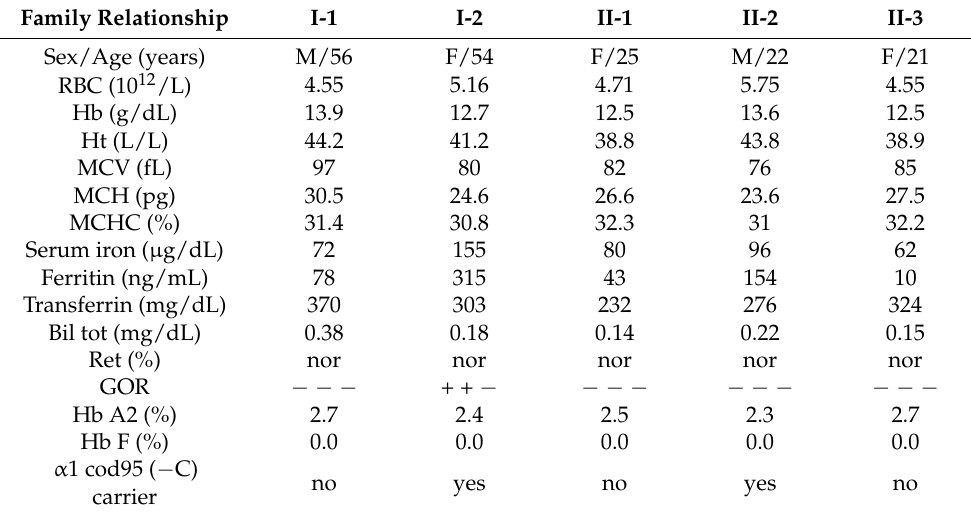
Table 2. Hematological and biochemical data and α -genotype of the family with Hb Campania . Family